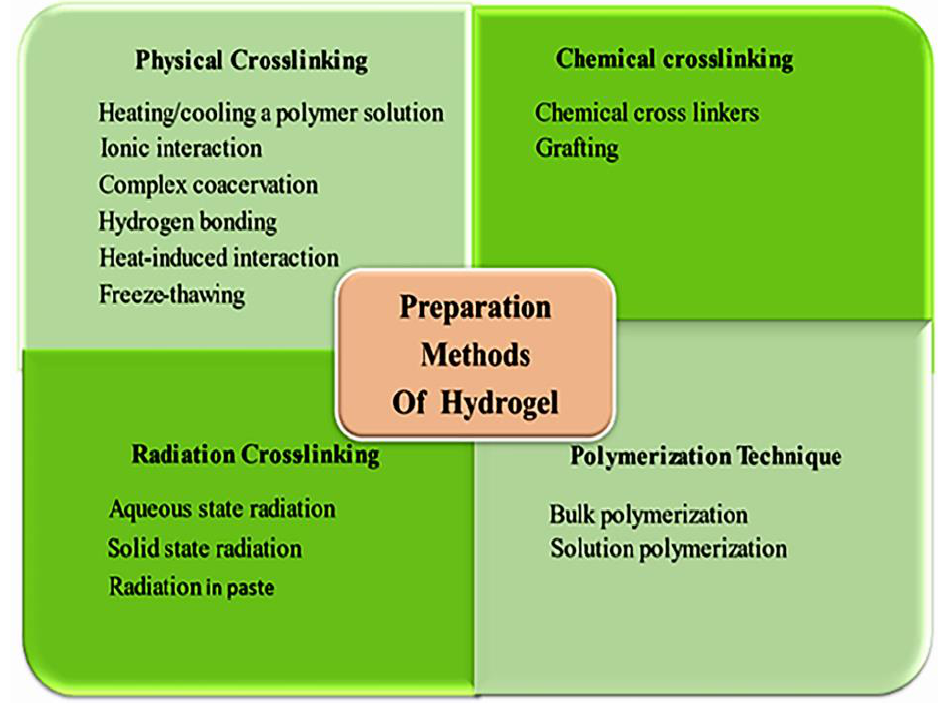
Figure 4. Different methods of preparation of hydrogel.